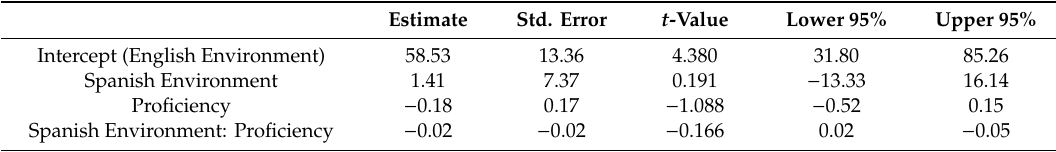
Table 3. Voice Onset Time Model with Proficiency Fixed E ff